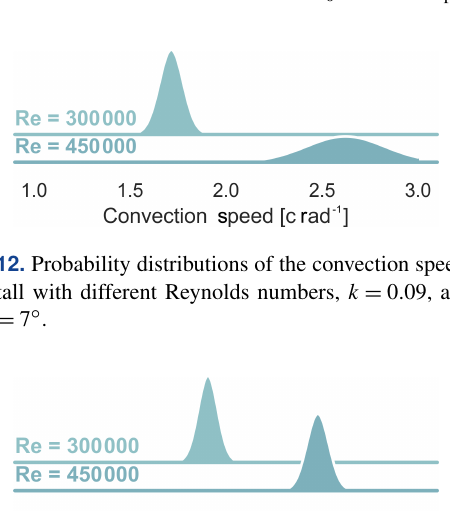
Figure 11. Probability distributions of the onset of dynamic stall with airfoil blowing and different phases of harmonic inflow ( τ ). U amp